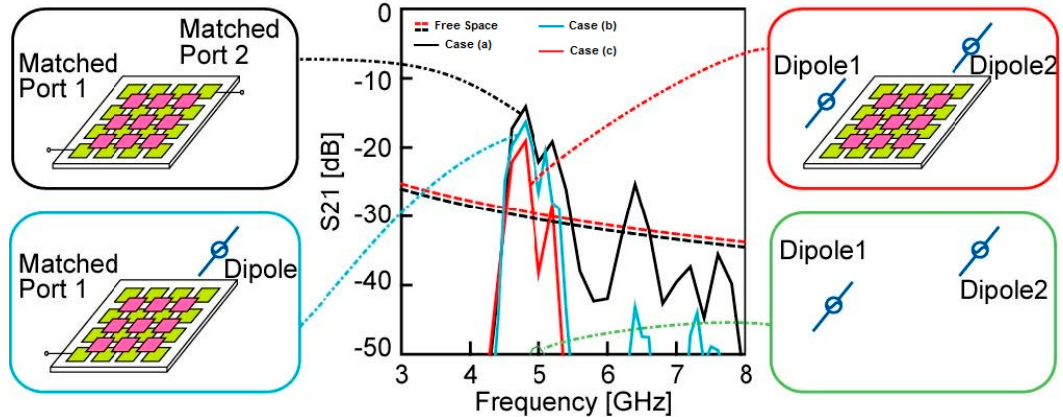
Figure 4. Transmission characteristics of the two-dimensional transmission line: The dotted lines show the transmission characteristics in free space.